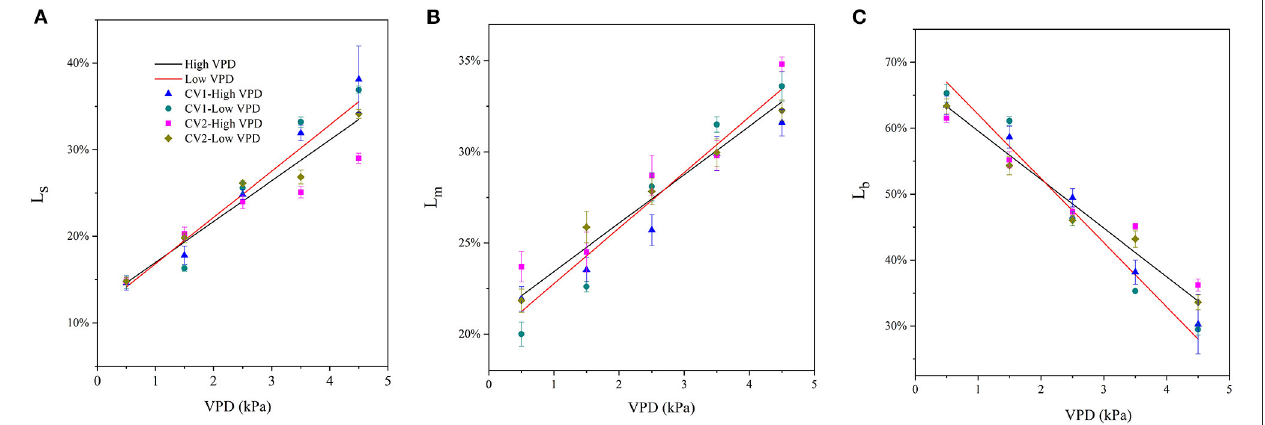
FIGURE 4 | Quantitative limitation analysis comparing stomatal [ (A) ; L s ], mesophyll [ (B) ; L m ], and biochemical [ (C) ; L b ] limitations imposed on the photosynthetic rate under varying VPD. The regression lines shown are: (A) HVPD, Ls = 0.0472 VPD + 0.122, R 2 = 0.86; LVPD, Ls = 0.0535 VPD + 0.115, R 2 = 0.89. (B) HVPD, L m = 0.0266 VPD + 0.208, R 2 = 0.88; LVPD, L m = 0.0305 VPD + 0.197, R 2 =